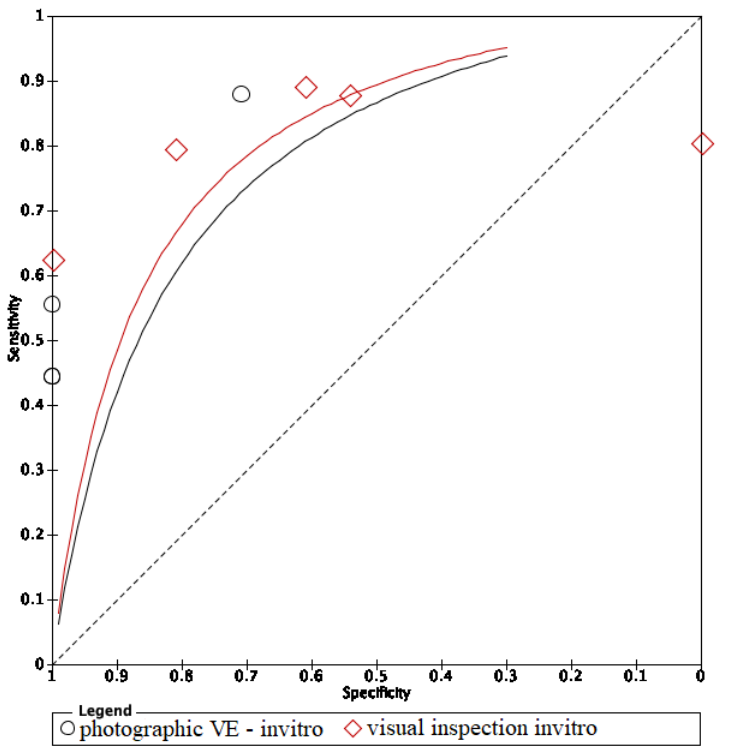
Figure 12. In vitro comparison of visual inspection and photographic visual examination. The ROC curve of in vivo fluorescence is directed towards the upper left corner than the curve of in vivo visual photographic examination (Figure 13).